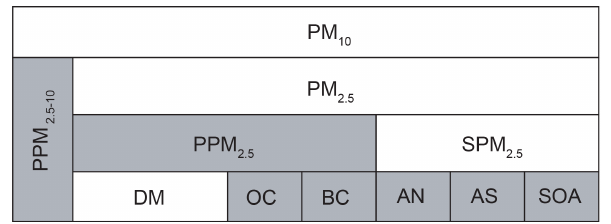
Figure 4. PM decomposition in the mesoscale CTM COSMO- MUSCAT: PM 10 is the bulk mass concentration of all particles with mean diameter d < 10µm. PM 10 is further composed into the two size fractions PPM 2 . 5 − 10 (primary matter) and PM 2 . 5 . PM 2 . 5 again contains primary contributions from BC, organic carbon (OC), and dust and metallic particles (DM). The secondary fraction is mainly composed of ammonium nitrate (AN), ammonium sulfate (AS), and secondary-aerosol (SOA) particles. Boxes colored in gray indicate direct model